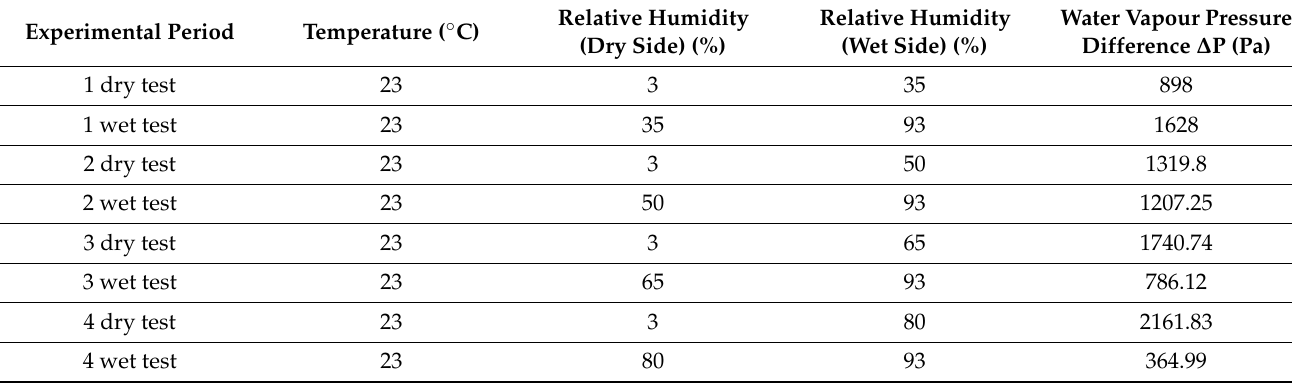
Table 1. ∆ P values for each of the test